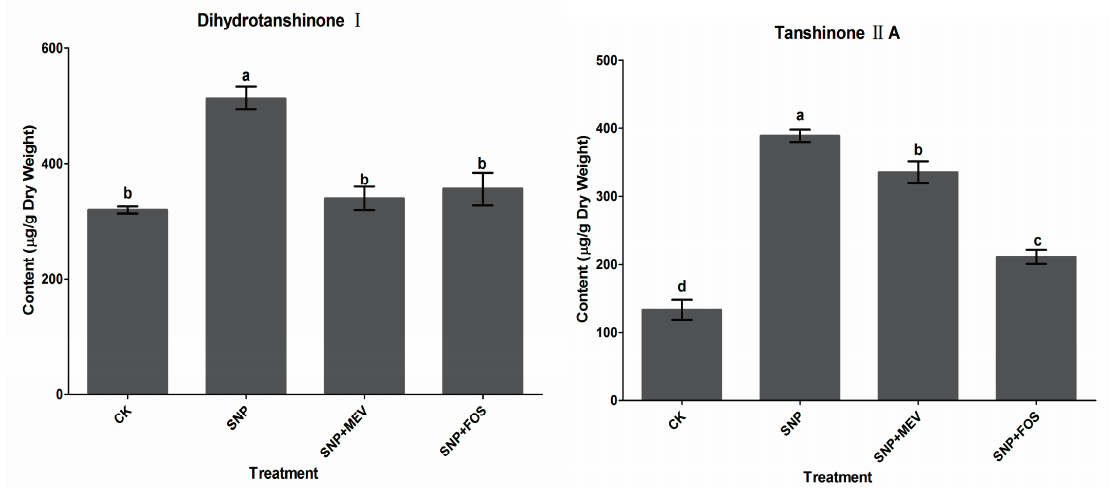
Figure 1. Effects of mevinolin (10 µM) and fosmidomycin (150 µM) on SNP-induced tanshinone production in S. miltiorrhiza hairy roots. CK, the control; SNP, sodium nitroprusside, 100 µM. Different letters (a, b, c and d) indicate significant difference at p ≤ 0.05. Means ± standard deviation (S.D.) ( n = 3) are